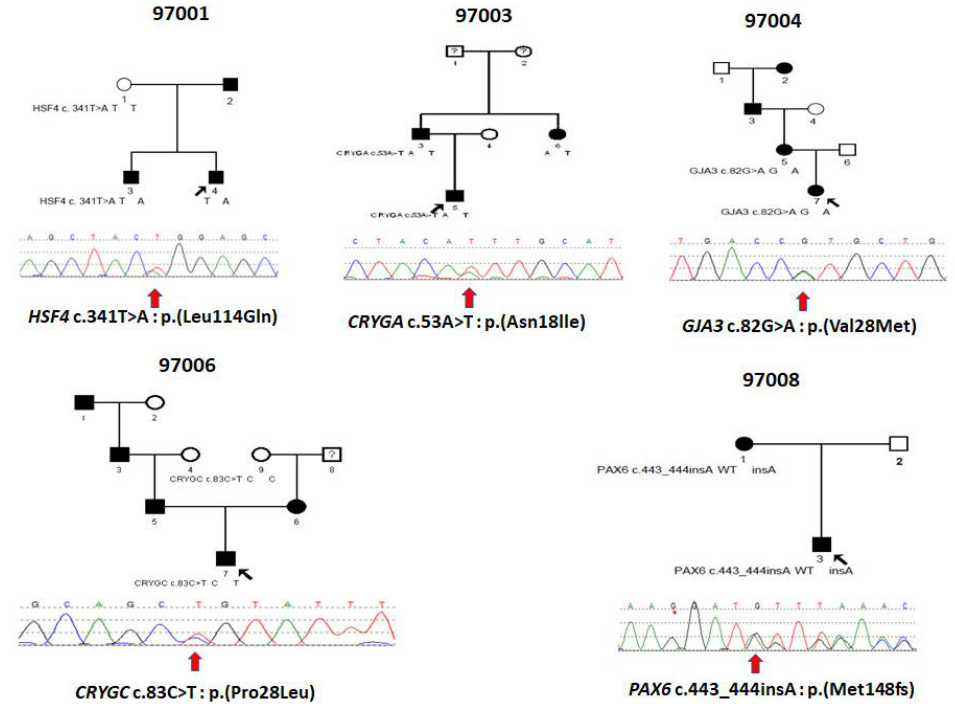
Figure 1. Pedigrees of Ukrainian families 97001, 97003, 97004, 97006 and 97008 with inherited congenital cataracts and sequence chromatograms of variants in the associated genes showing in the probands of each of the five families. Circles represent females and squares males. Filled symbols indicate individuals affected by congenital cataracts. Black arrows indicate probands and red arrows below the sequence tracings indicate the sequence variations.